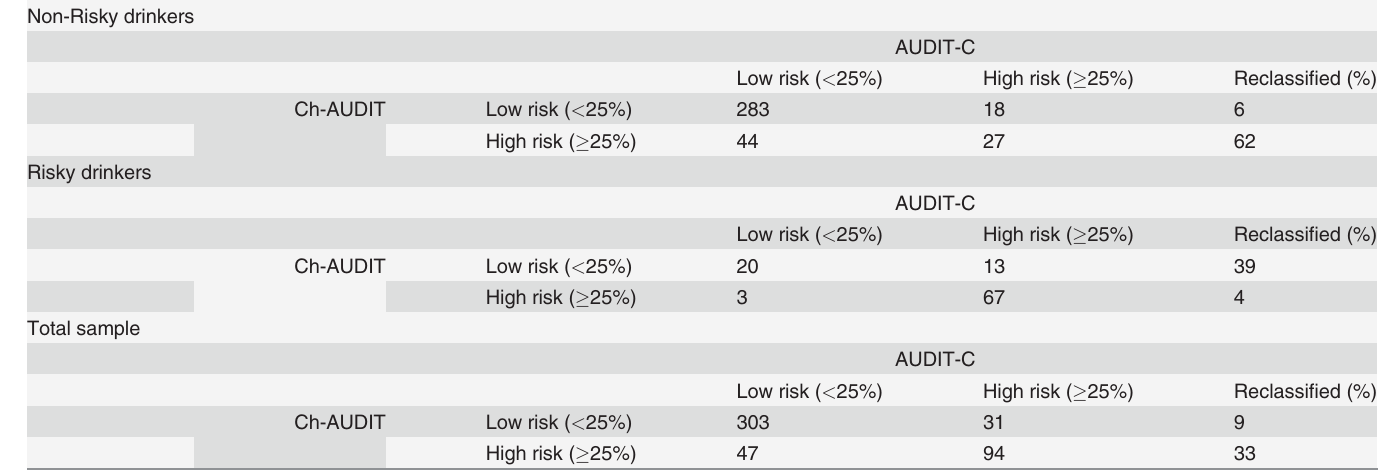
Table 4. Reclassi fi cation performances of Ch-AUDIT and AUDIT-C for identifying risky drinking male patients in primary care setting. Non-Risky